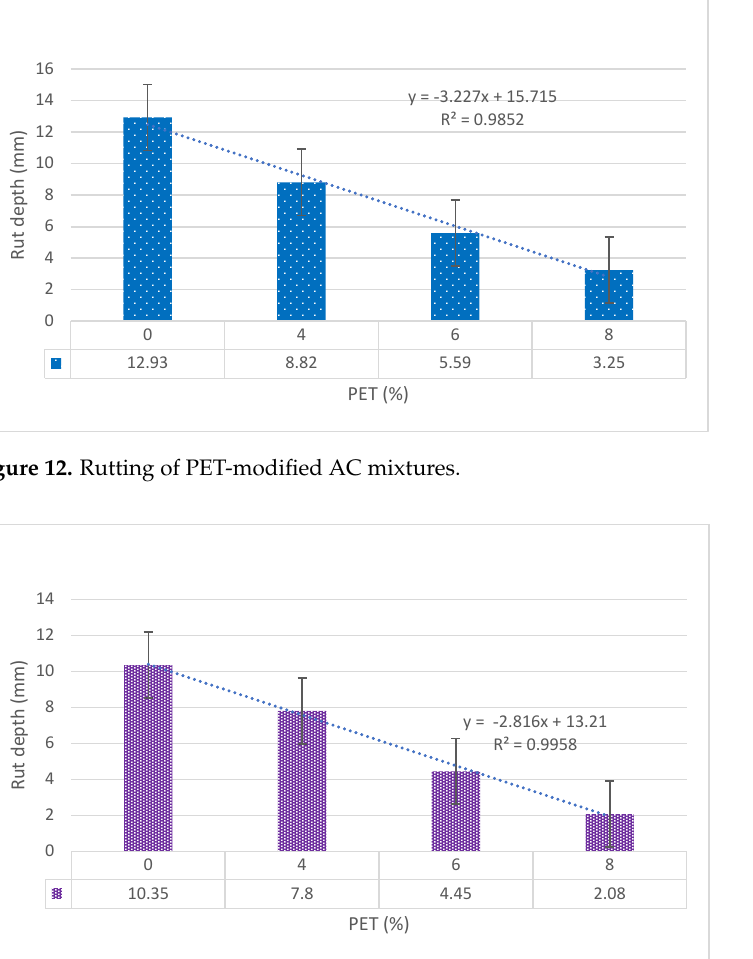
Figure 13. Rutting of PET-modified SMA mixtures.